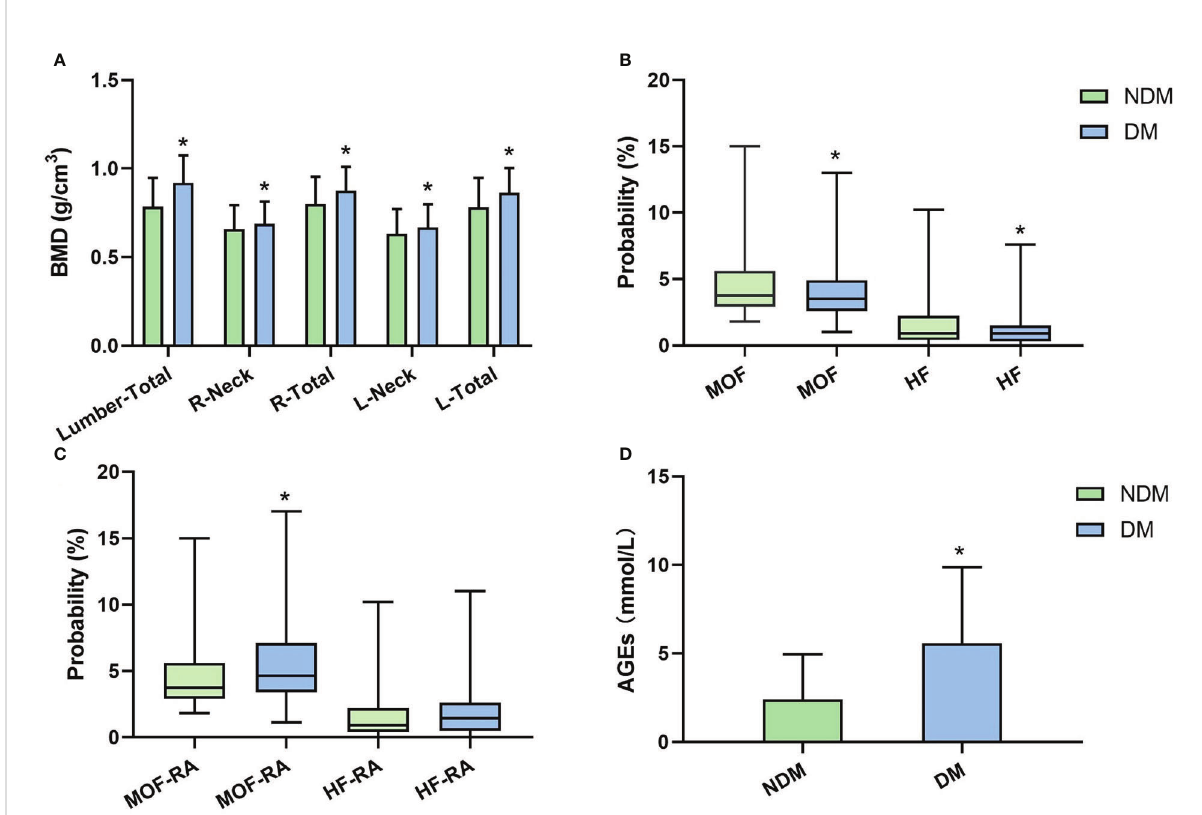
FIGURE 1 BMD, FRAX values (without correction), FRAX values (corrected by rheumatoid arthritis [RA]), and AGEs level between NDM and DM groups. (A) BMD comparation in each area; (B) major osteoporotic fractures (MOF) and hip osteoporotic fractures (HF) comparation; (C) Adjusted MOF by RA (MOF-RA) and adjusted MOF by RA (HF-RA) comparation; (D) AGEs comparation. (* P <0.05 compared to the NDM